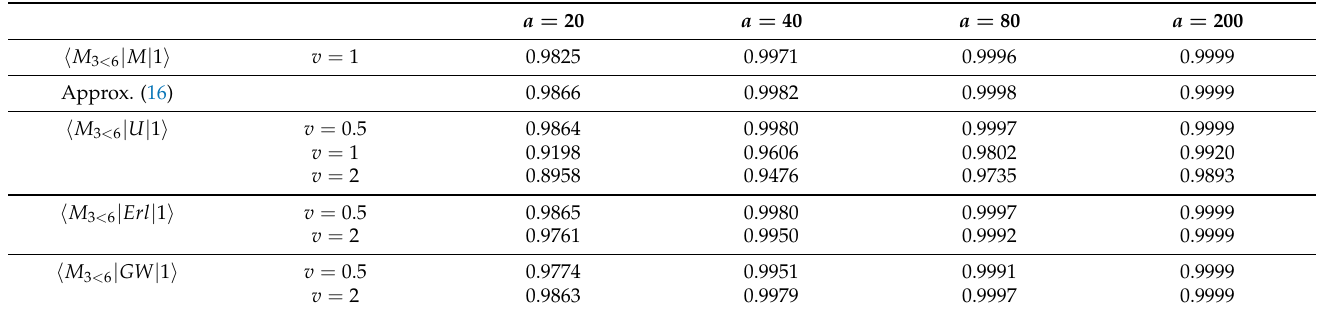
Table 1. K av of (cid:104) M 3 < 6 | GI | 1 (cid:105) system under rare failures. a = 20 a =